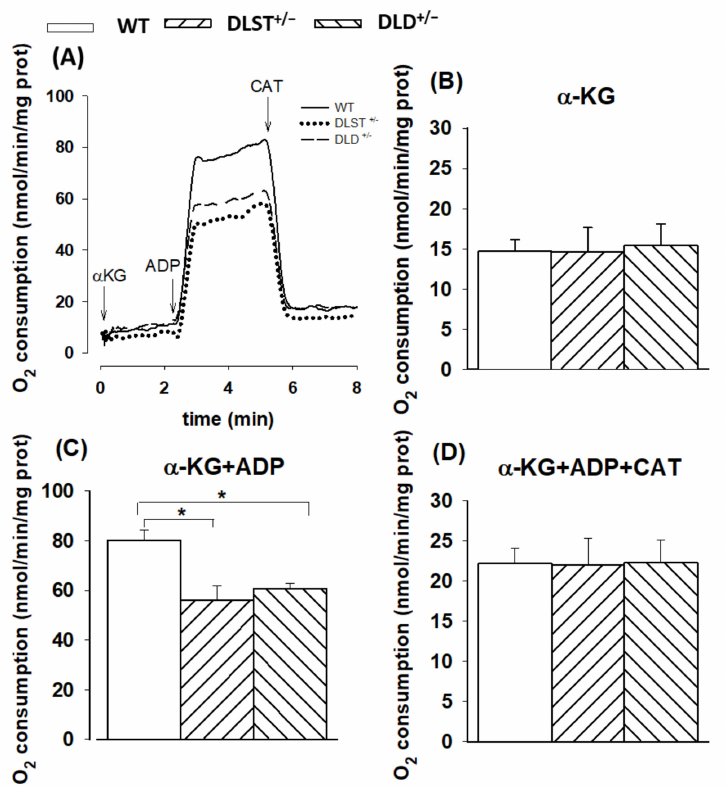
Figure 1. Oxygen consumption of mitochondria isolated from wild-type and KGDHc subunit heterozygote KO mice respiring on α -ketoglutarate ( α -KG) in the absence ( B ) or presence ( C , D ) of ADP, and after addition of carboxyatractilozide (CAT), ( D ). ( A ) Trace are representatives of experiments with wild-type mice (WT; solid line), dihydrolipoyl succinyltransferase transgenic mice (DLST +/ − ; dotted line), and dihydrolipoyl dehydrogenase transgenic mice (DLD +/ − ; dashed line). Oxygen consumption was monitored by high-resolution respirometry. Mitochondria (0.1 mg/mL) were incubated in a standard medium, as described under Materials and Methods. Afterwards, α -KG (5 mM), ADP (2 mM); ( B , C ), and carboxyatractyloside (CAT; 2 µ M); ( D ) were given. White bars: WT; bars with left diagonal stripes: DLST +/ − mutation; bars with right diagonal stripes: DLD +/ − mutation. The results are expressed as the means of oxygen consumption in nmol/min/mg protein ± SEM ( N = 4–16). Statistically significant differences are indicated by asterisks; * p <